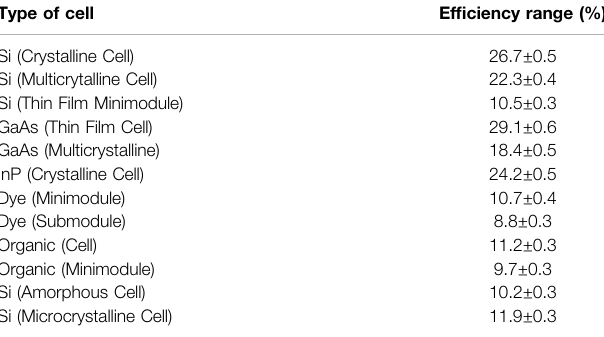
TABLE 1 | The ef fi ciencies of different types of solar cells (Green et al., 2019). Type of